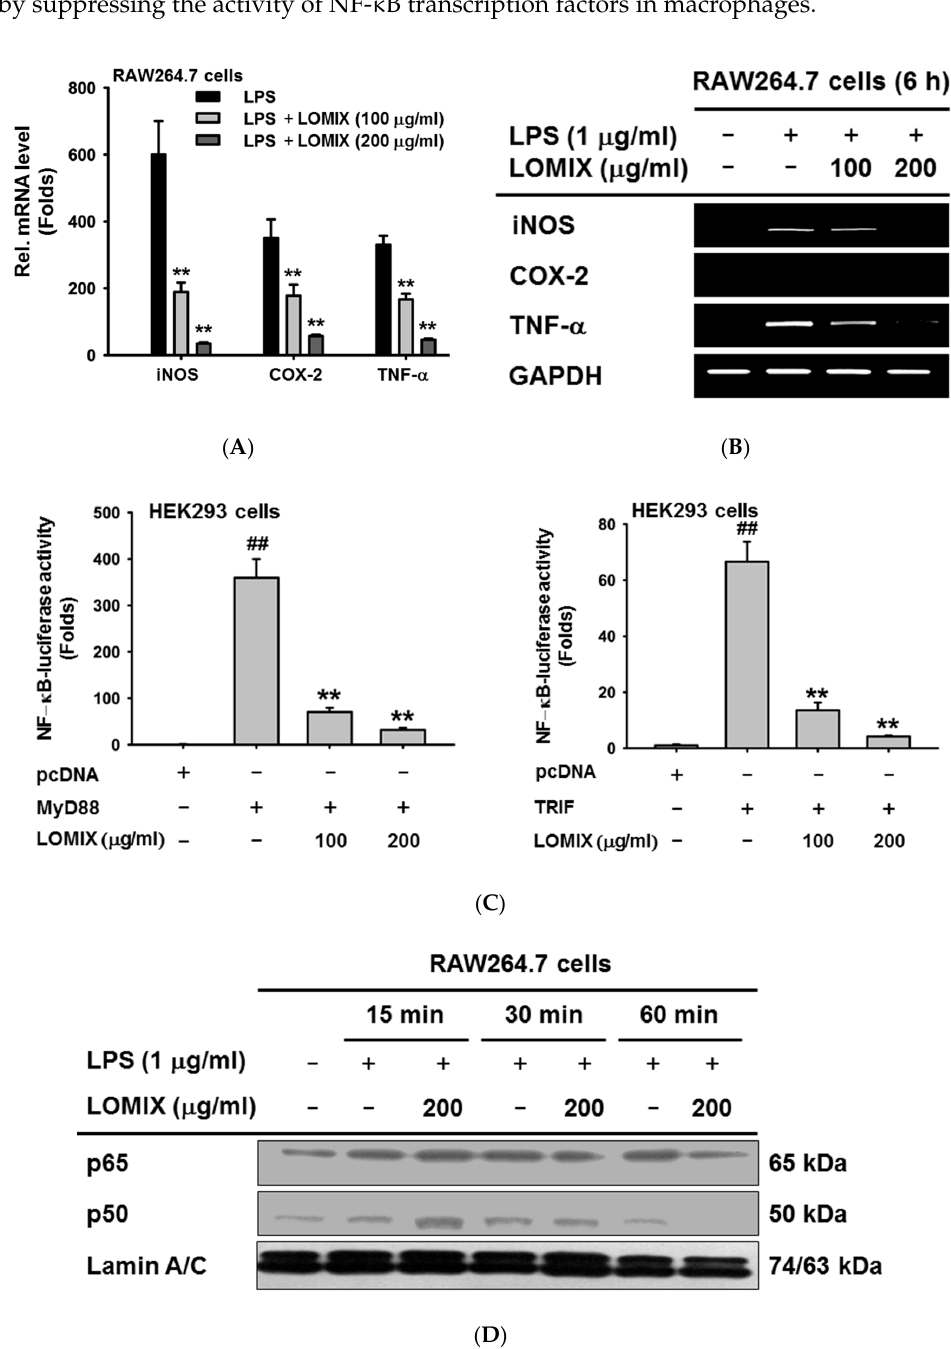
Figure 2. LOMIX suppresses mRNA expression of inflammatory genes by inhibiting NF- κ B. RAW264.7 cells pretreated with the indicated doses of LOMIX for 30 min were treated with LPS (1 µg/mL) for 6 h, and mRNA expression levels of iNOS, COX-2, and TNF- α were determined by ( A )